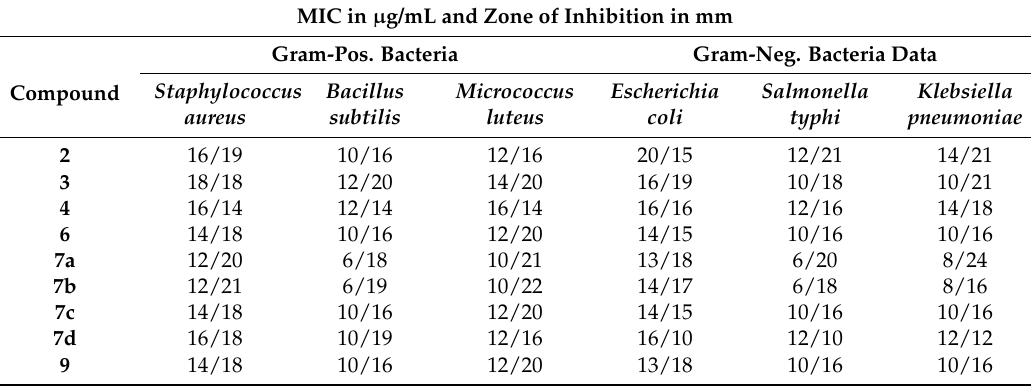
Table 2. Antibacterial activity of newly synthesized